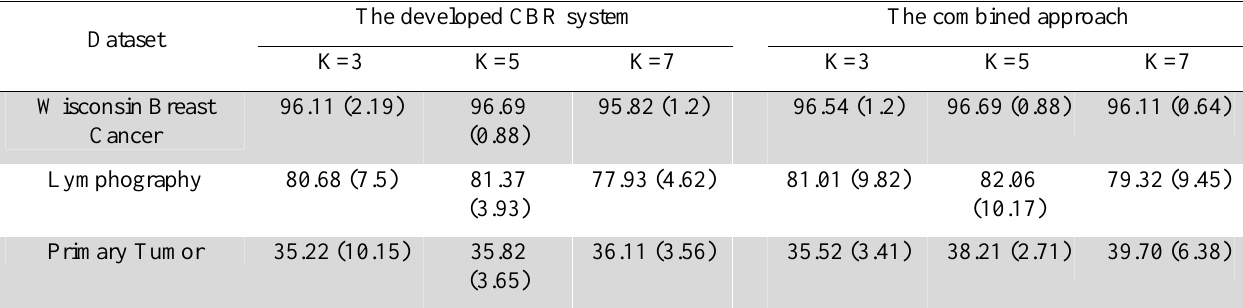
The average and standard deviation accuracy for the developed CBR system and the combined approach Dataset